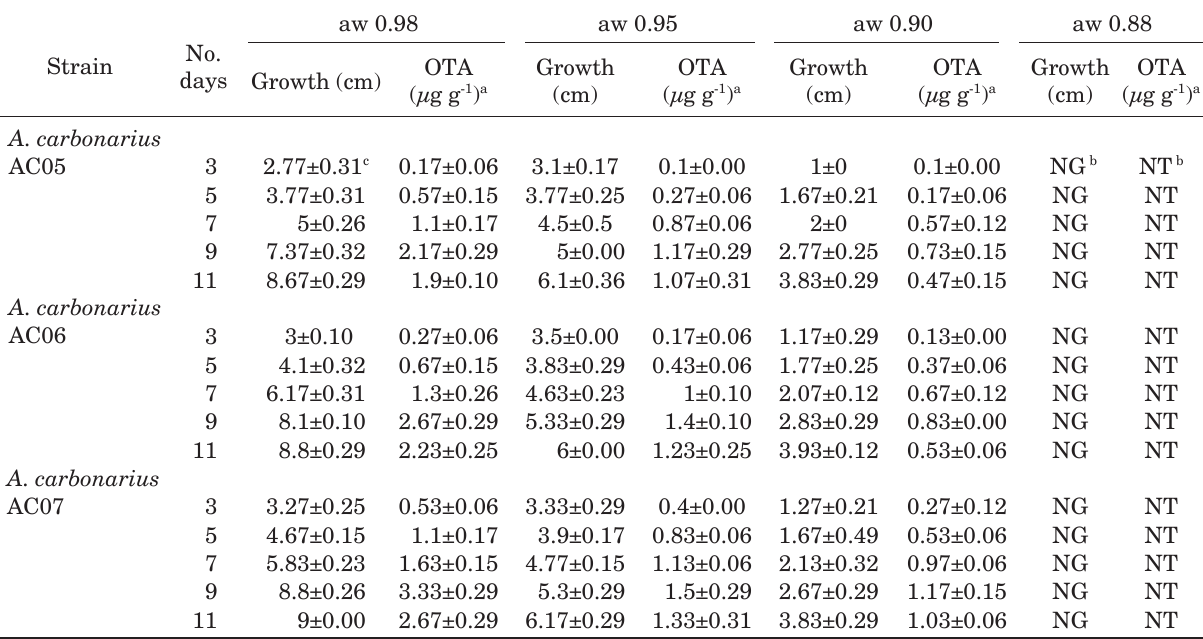
Table 2. Mycelial growth and production of OTA by three A. carbonarius strains on YES (yeast extract sucrose) agar at 30°C and at different water activity levels.